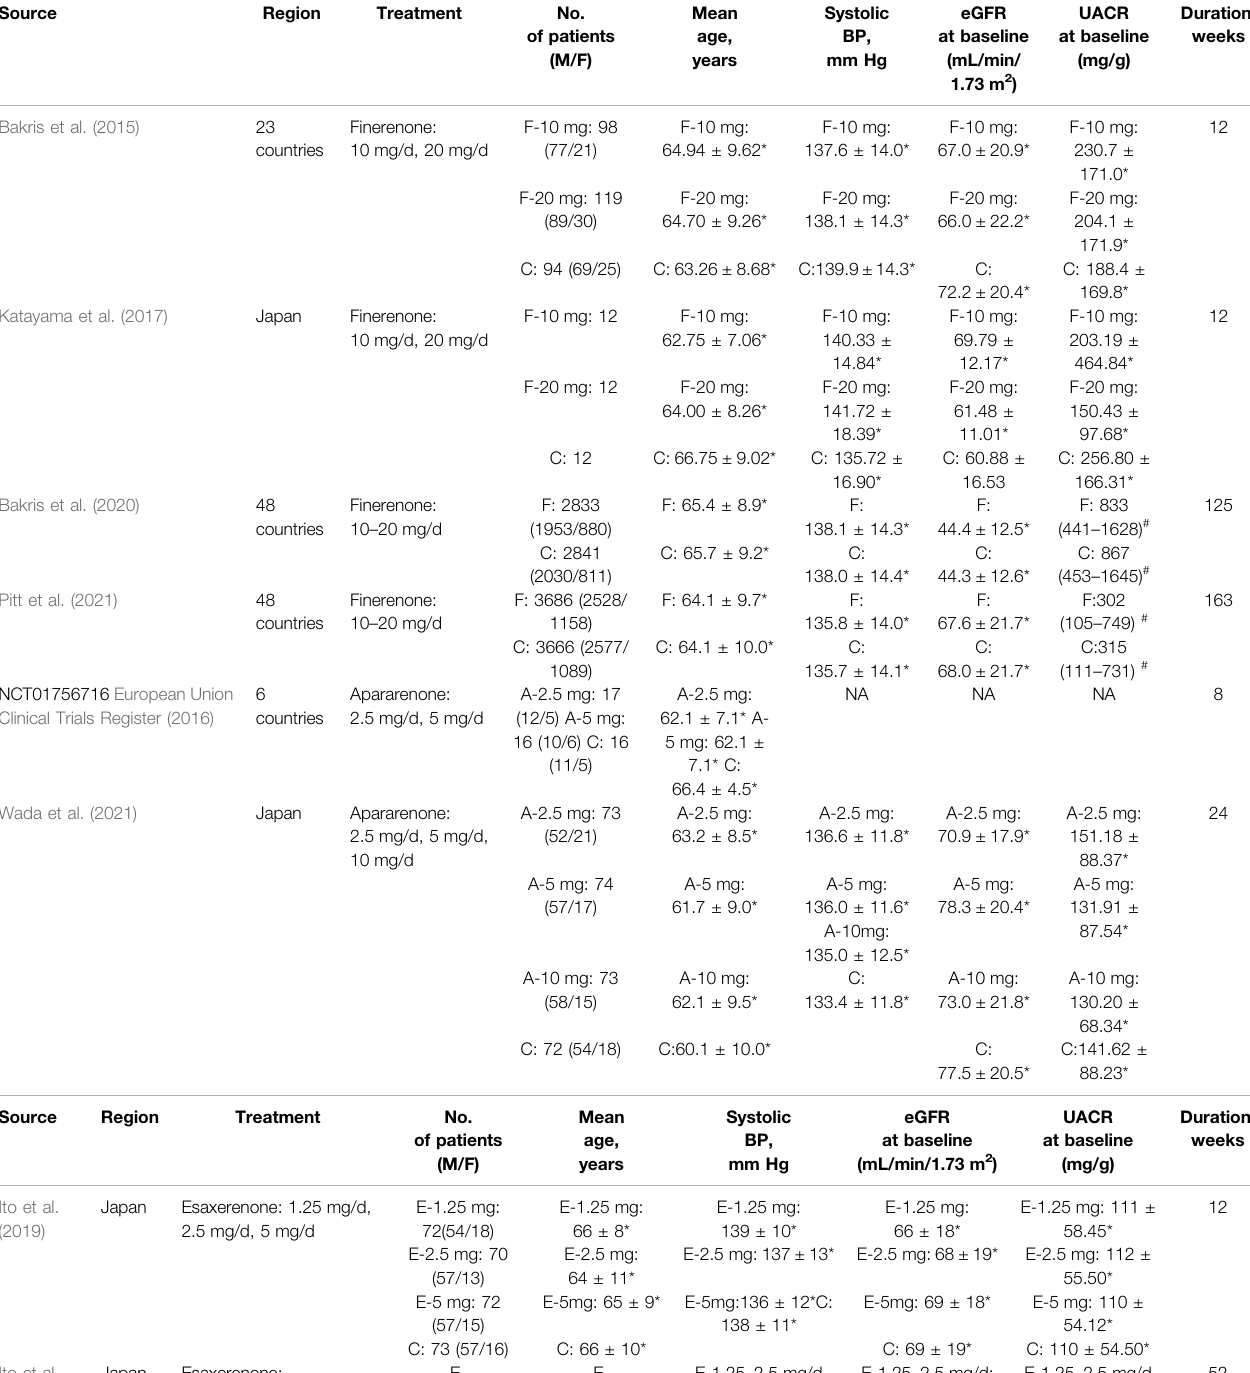
TABLE 1 | Characteristics of included